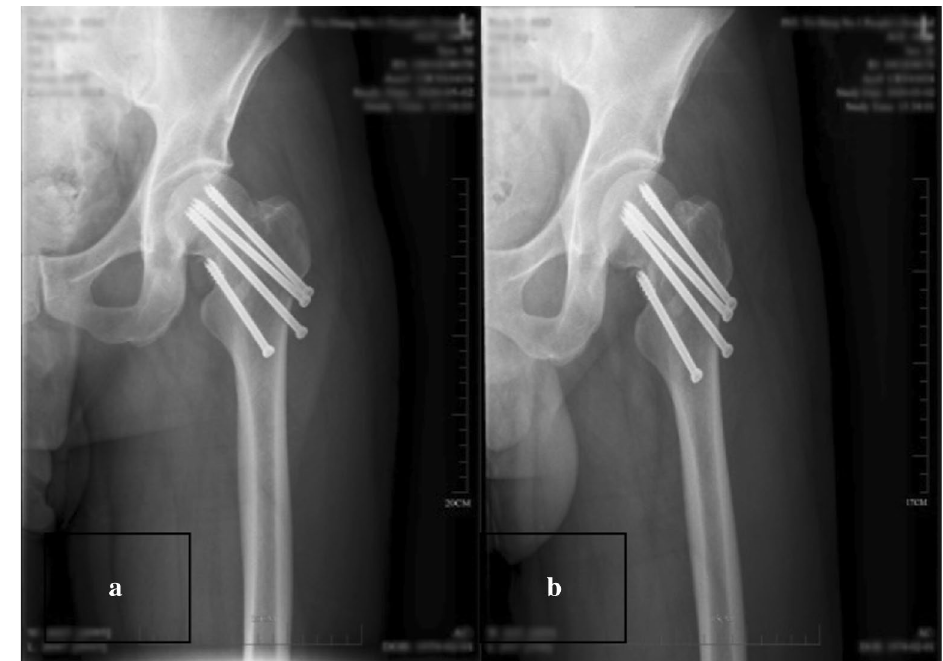
Figure 13. ( a , b ) The X-ray positive radiographs reviewed on the second day after surgery ( Note : The patient was a 47-year-old male. He was admitted to the hospital for 2 h due to a high fall injury).